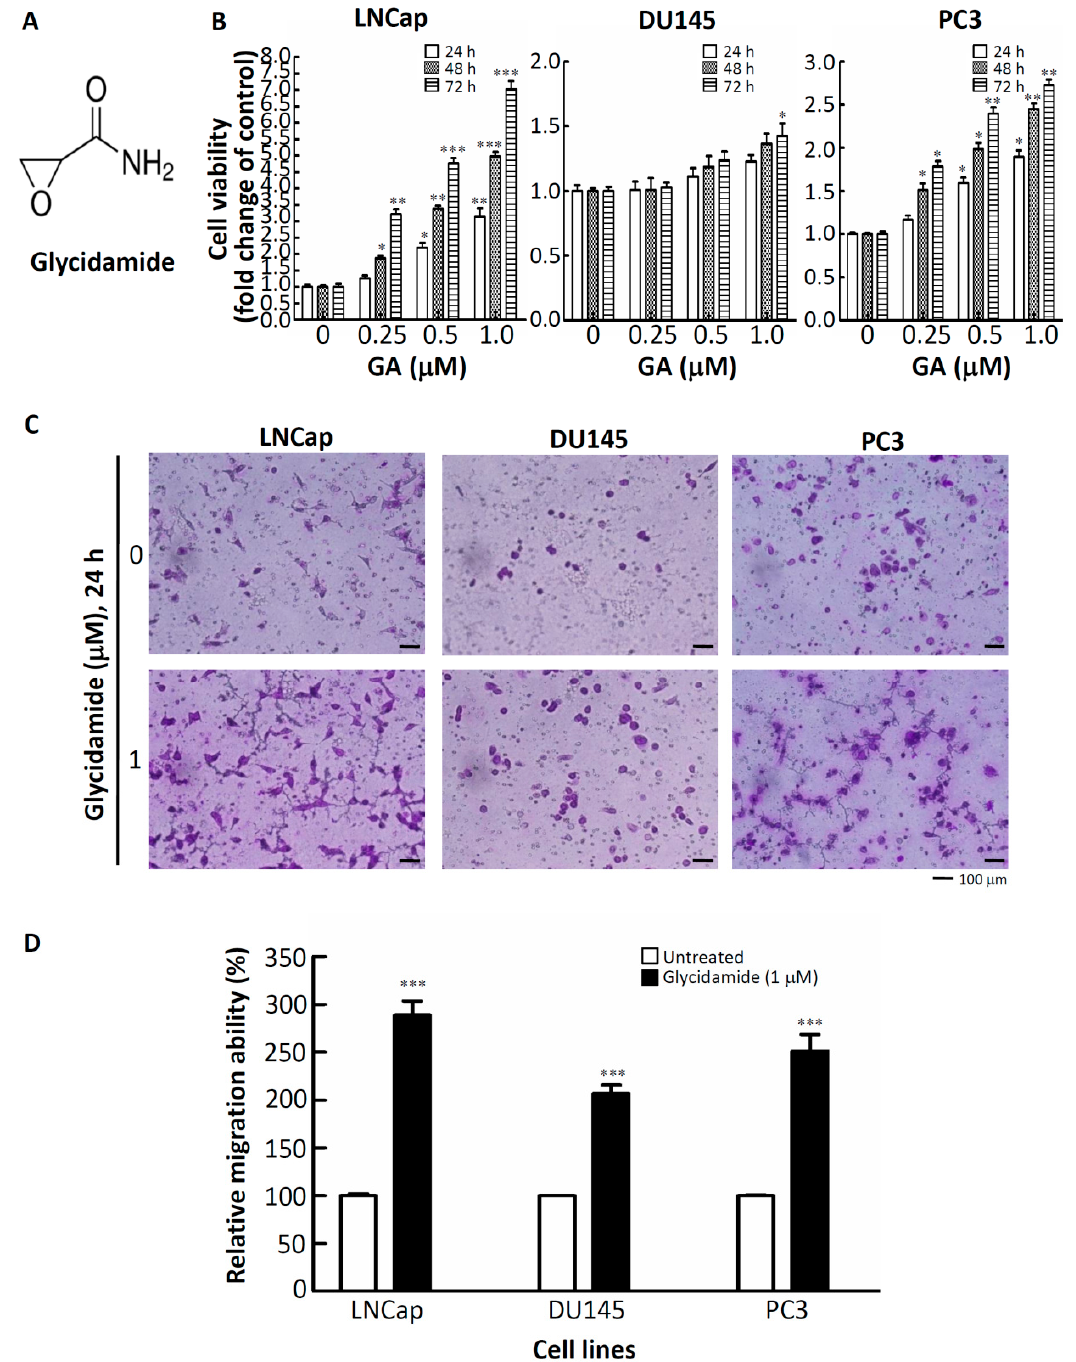
Figure 1. Glycidamide (GA) promotes cell growth and migration and contributes to malignant phenotypes of prostate cancer cells. ( A ) Chemical structure of glycidamide (GA). ( B ) The effects of GA on cell viability were determined in a panel of prostate cancer cell lines. Cells were treated with GA at the indicated concentrations in a10% fetal bovine serum (FBS)-supplemented medium for 24, 48, and 72 h, and cell viability was assessed using a crystal violet staining method. Bars, SD ( n = 6). ( C , D ) The effects of GA on the migratory activity of a panel of prostate cancer cell lines after 24 h of treatment. * p < 0.05, ** p < 0.01, *** p < 0.001. Values are presented as the mean ± SD of three independent experiments. SD: standard deviation.